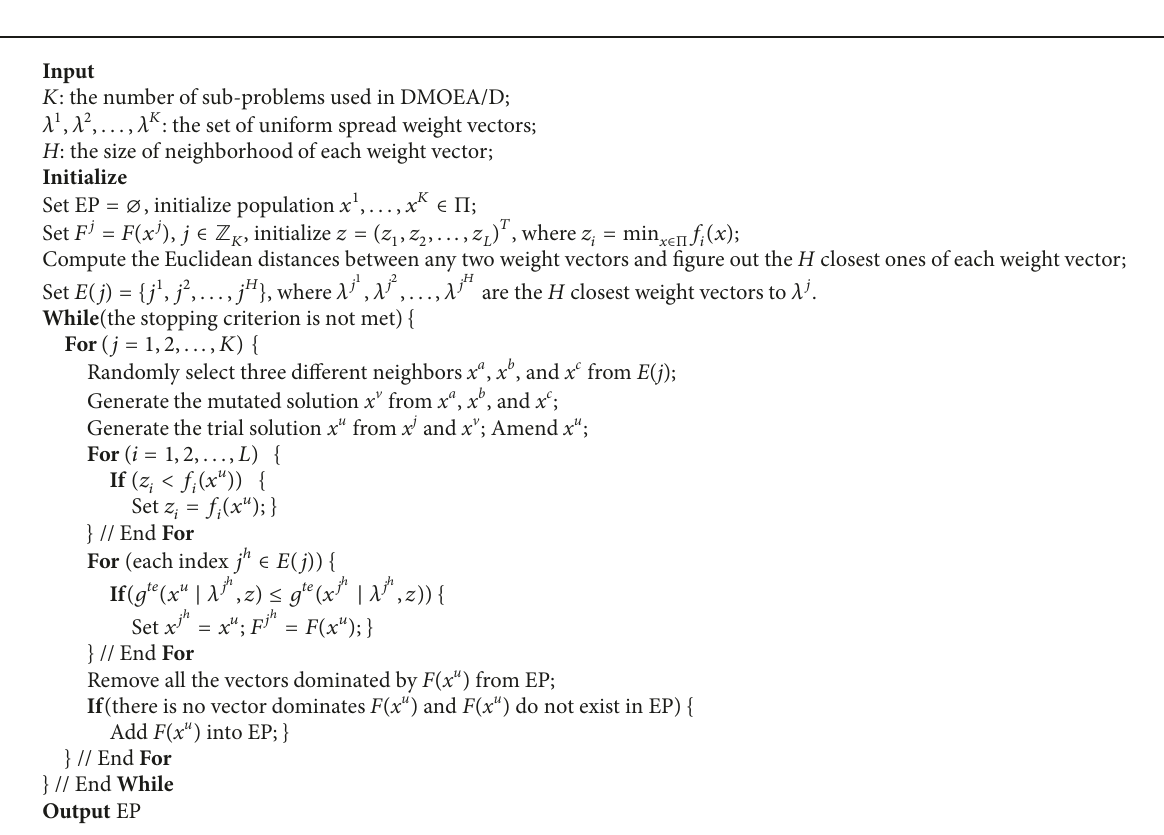
Algorithm 1: Algorithm